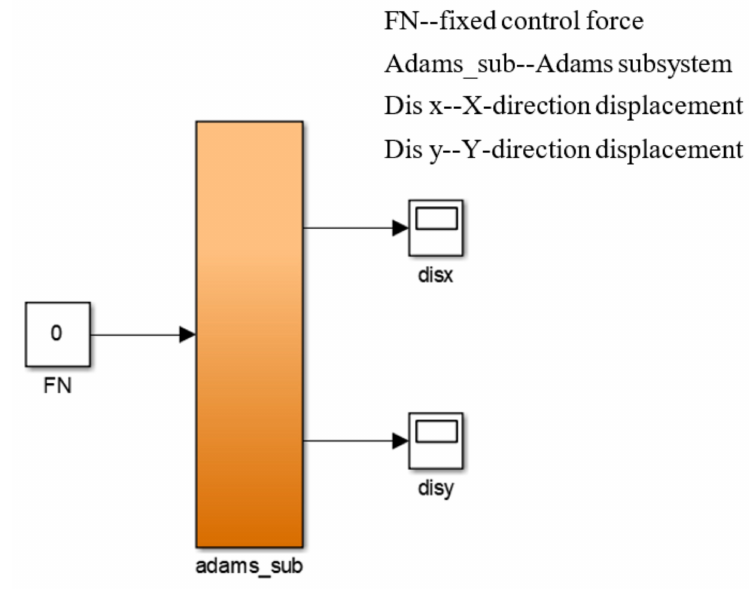
Figure 6. Joint simulation model of open-loop